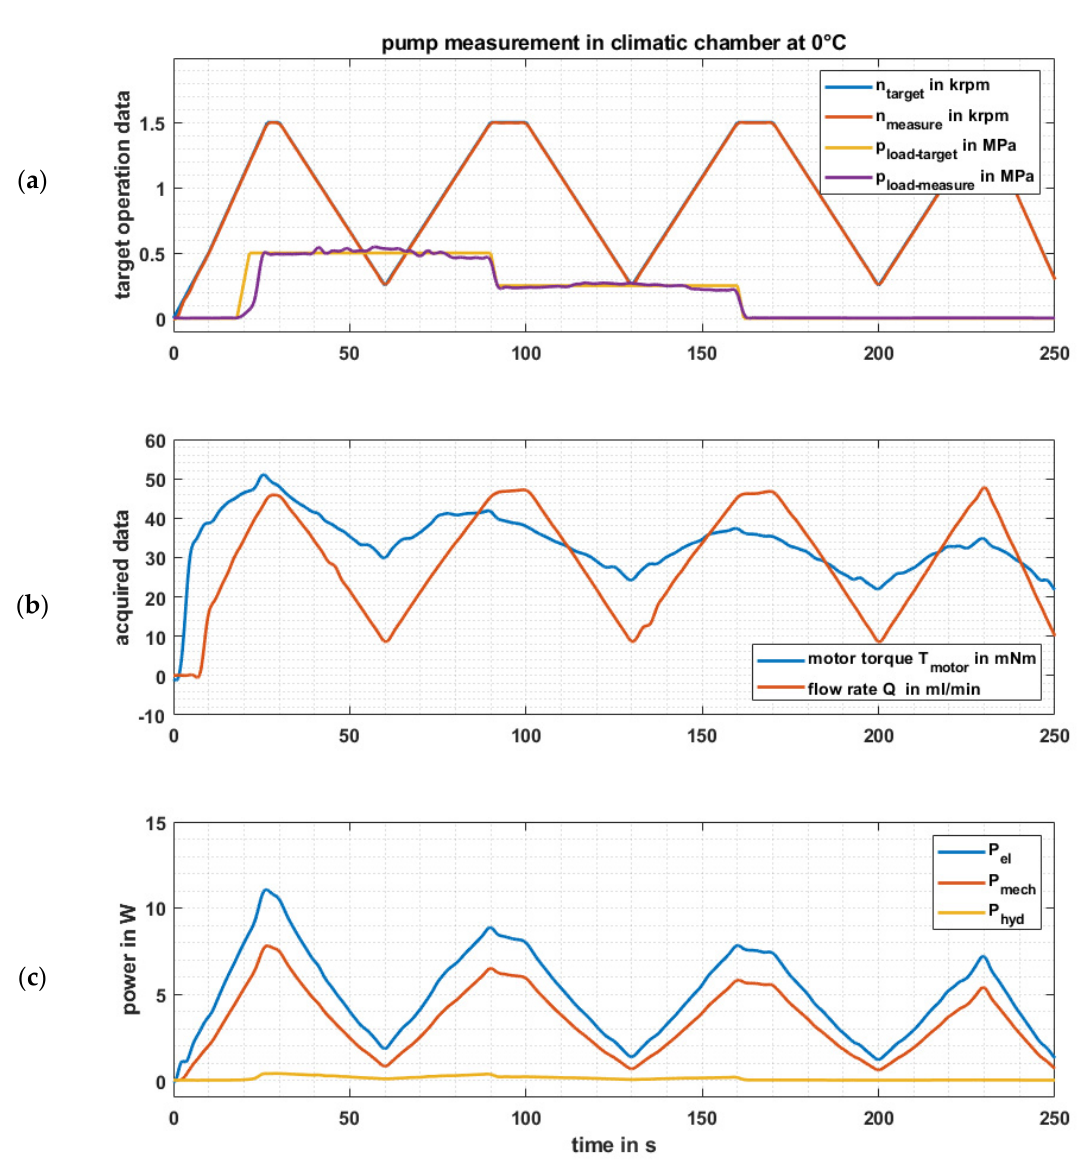
Figure 28. Results of the test cycle at room temperature (20 °C); ( a ) target test cycle motor speed n and load pressure p; ( b ) measured torque and flow rate; ( c ) electrical, mechanical and hydraulic power.